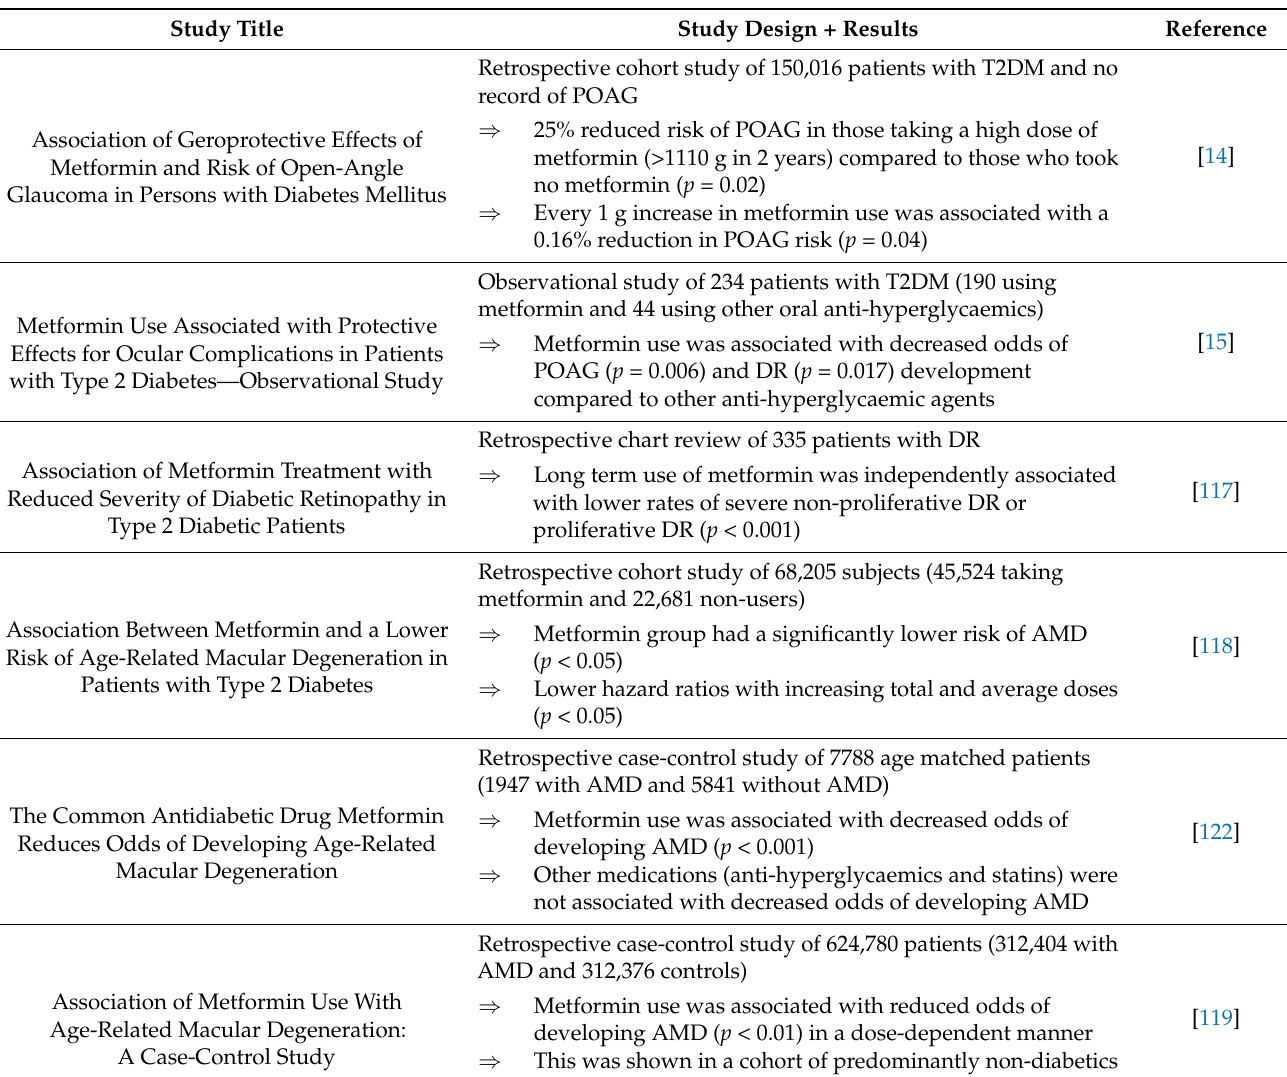
Table 2. Studies of metformin’s effect on a variety of ocular